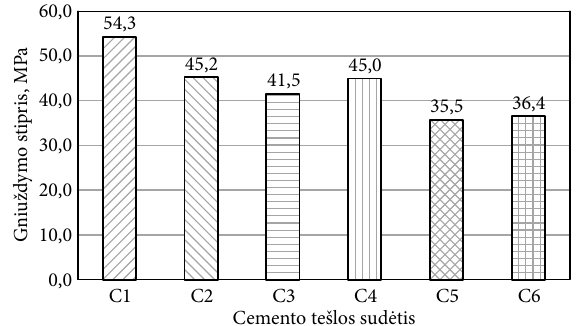
6 pav. Cementinio akmens lenkimo stiprio kitimas Fig. 6. Changes in the bending strength of hardened cement paste